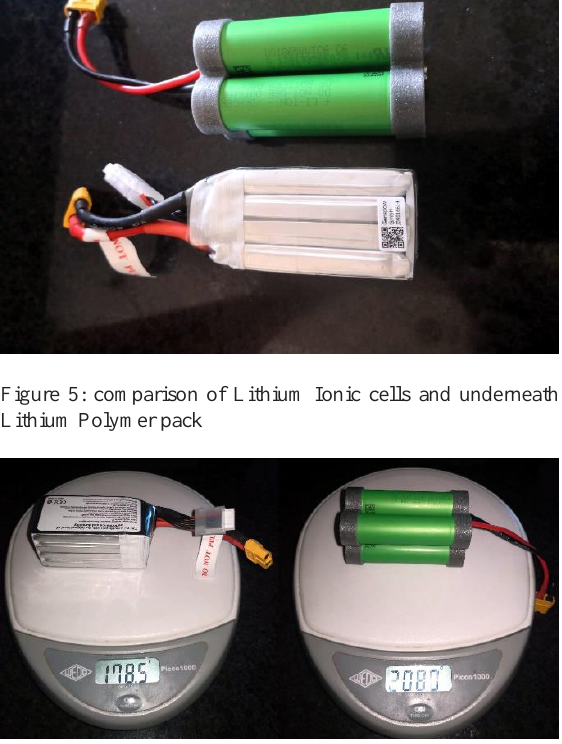
Figure 6: weight comparison LiPo 178,5g, LiIo 208,0 g The LiPo sample pack in the picture above (left side) has a capacity of 1550mA, the LiIo pack on the right offers 3000mAh So at nearly the same size and weight, the LiPo offers 22,94Wh, the LiIo